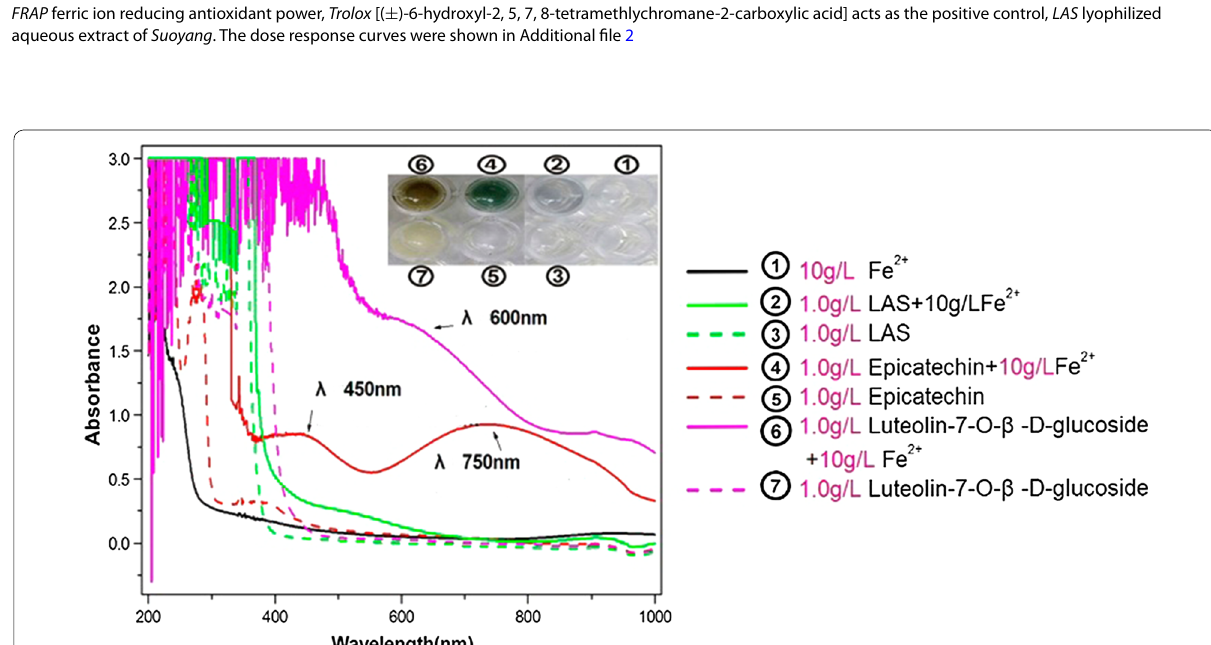
IC 50 value is defined as the concentration of 50% effect percentage and expressed as mean software. Means values with different superscripts (a, b or A, B) in the same row are significantly different ( p < 0.05), while with same superscripts are not significantly different ( p > 0.05)